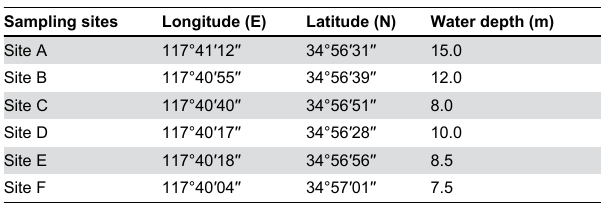
Table 1. Location (longitude and latitude) and water depth of each sampling sites (site A, site B, site C, site D, site E, site F) in the Zhou cun drinking water reservoir, eastern